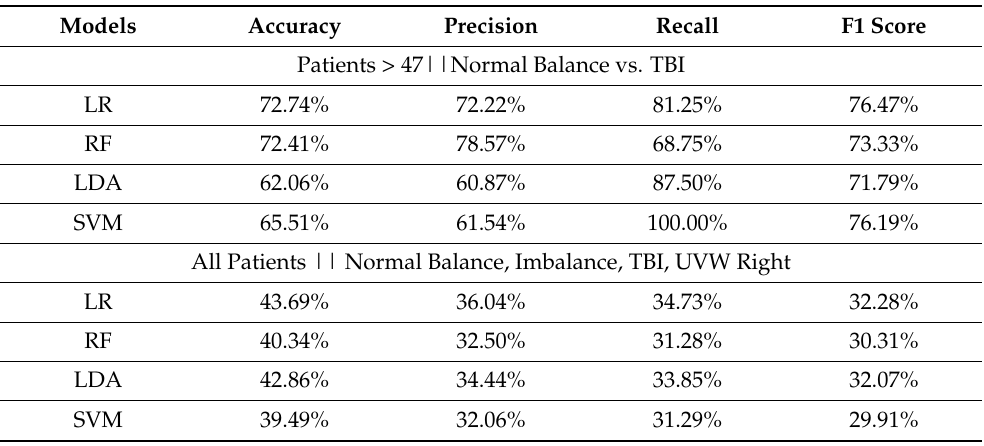
Table 1. Machine learning models—prediction metrics performance.